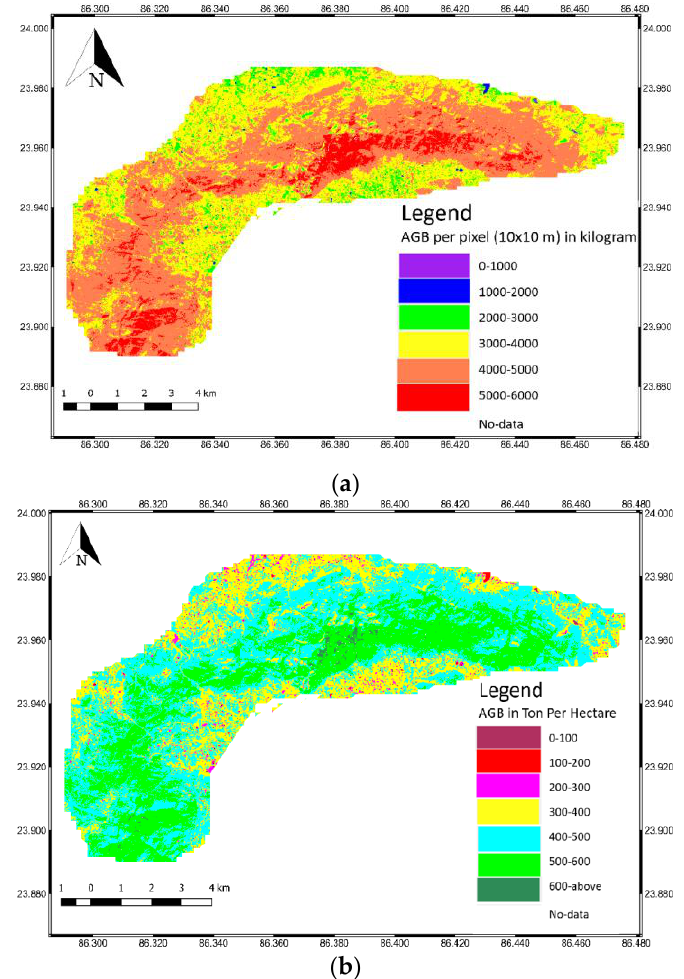
Figure 4. The forest AGB calculated from Sentinel-2 imagery in kg per pixel ( a ) and tons per hectare ( b ) for the Tundi reserved forest, Jharkhand, India.